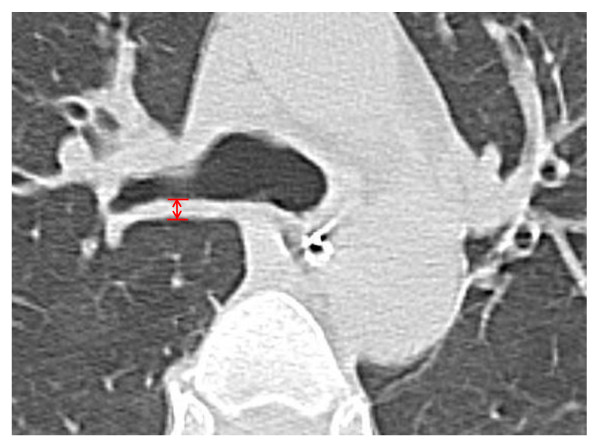
Indices of bronchial wall thickness on HRCT scan. Measurement position of bronchial-wall thickness (arrows). HRCT, helical high-resolution computed tomography.